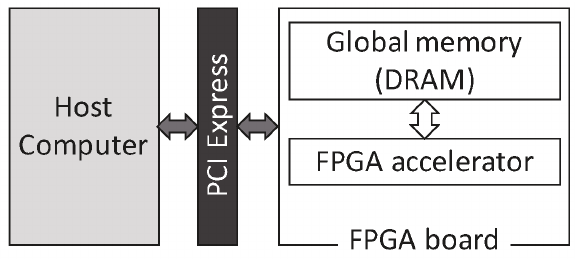
Fig. 8. Diagram of the CPU-FPGA heterogeneous process- ing system for molecular dynamic